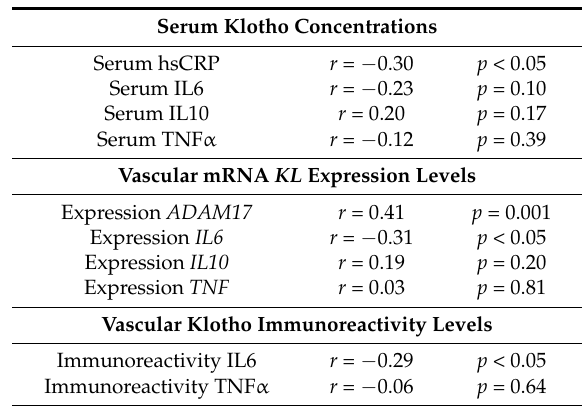
Table 3. Association between serum and vascular expression levels of Klotho with inflammatory parameters assessed by partial correlation